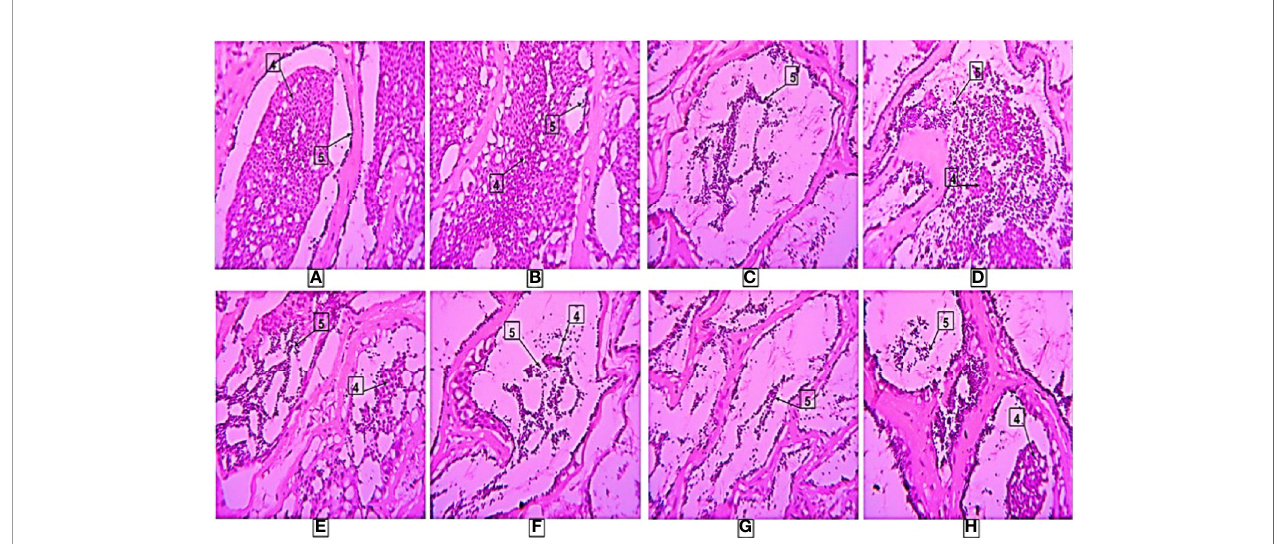
FIGURE 7 | Histological results in different treatments. Here, 4-Spermatids, 5-Spermatozoa, (A – F) are treatments. The photographs were taken at a magni fi cation of